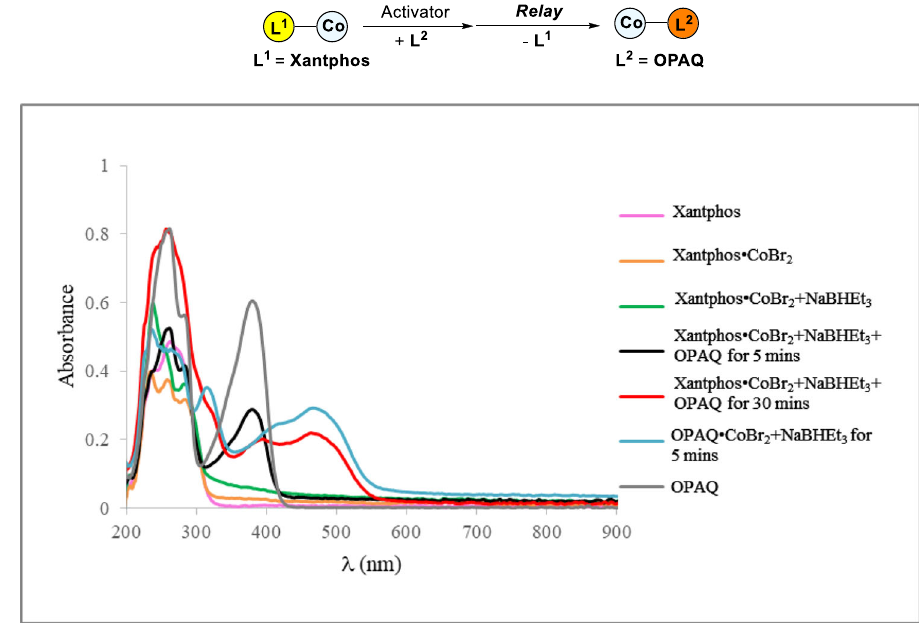
Fig. 8 Absorption spectra of ligand relay process between Xantphos and OPAQ. The absorption spectra experiment is conducted under nitrogen using optic fi ber